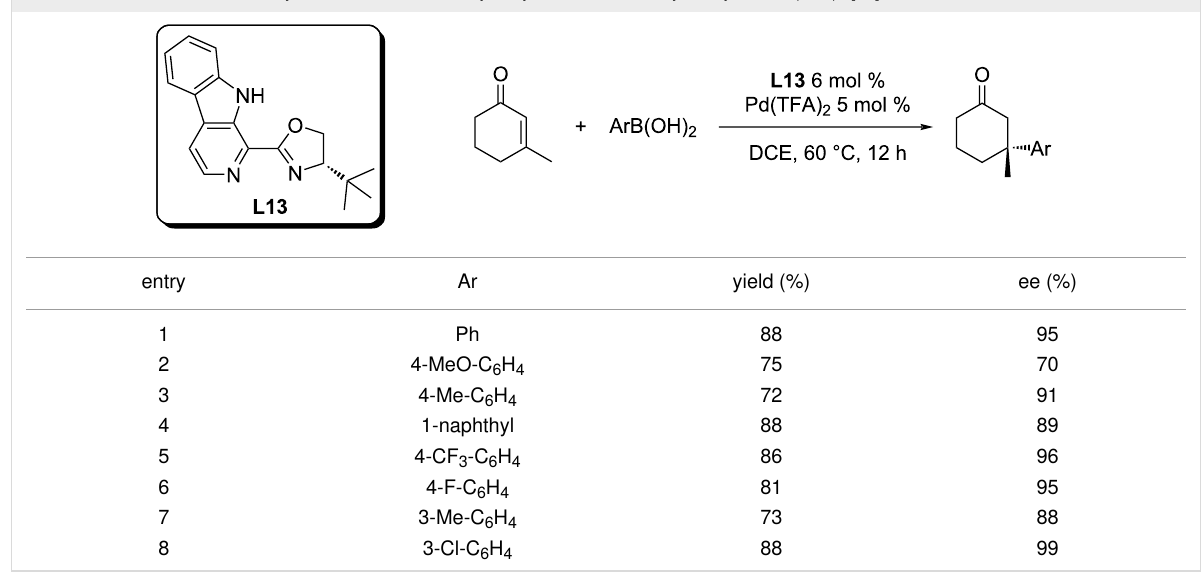
Table 32: Addition reactions of arylboronic acids to 3-methyl-2-cyclohexenone catalysed by L13 /Pd(TFA) 2